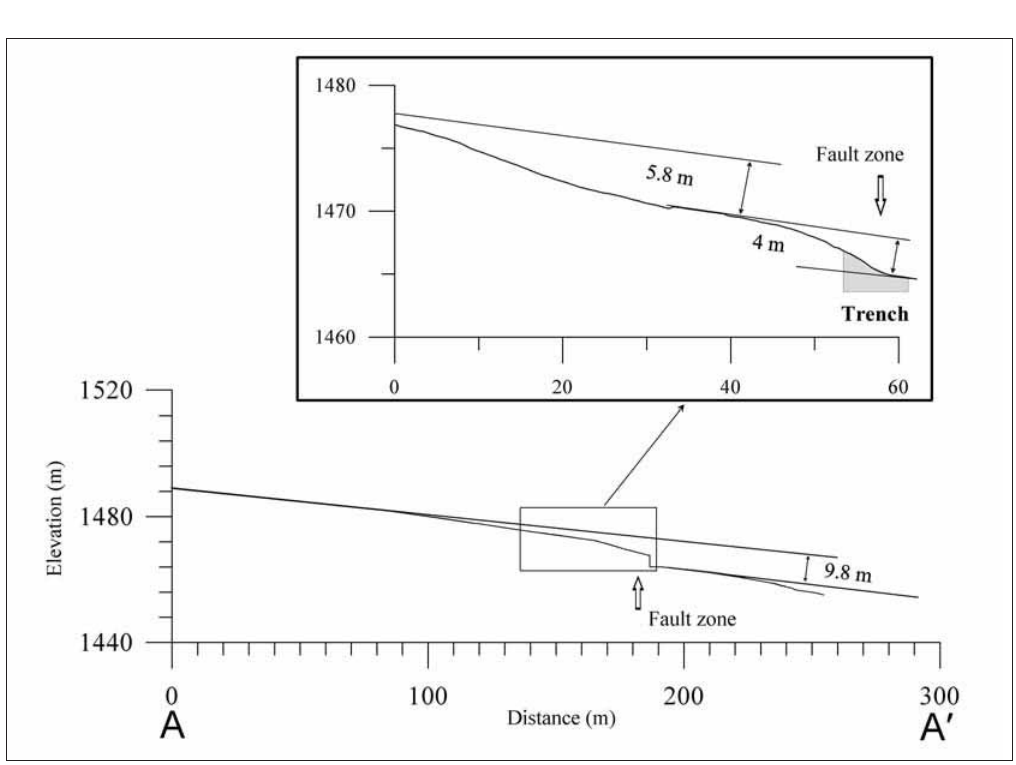
Fig. 5. Topographic profile across the fault trace near trench sites. This profile indicates a total vertical dis- placement of 9.8 ± 0.3 m across two fault scarps. Trench 1 exposed the shorter of these fault scarps (4 m high) as a zone of shearing a few meters wide.